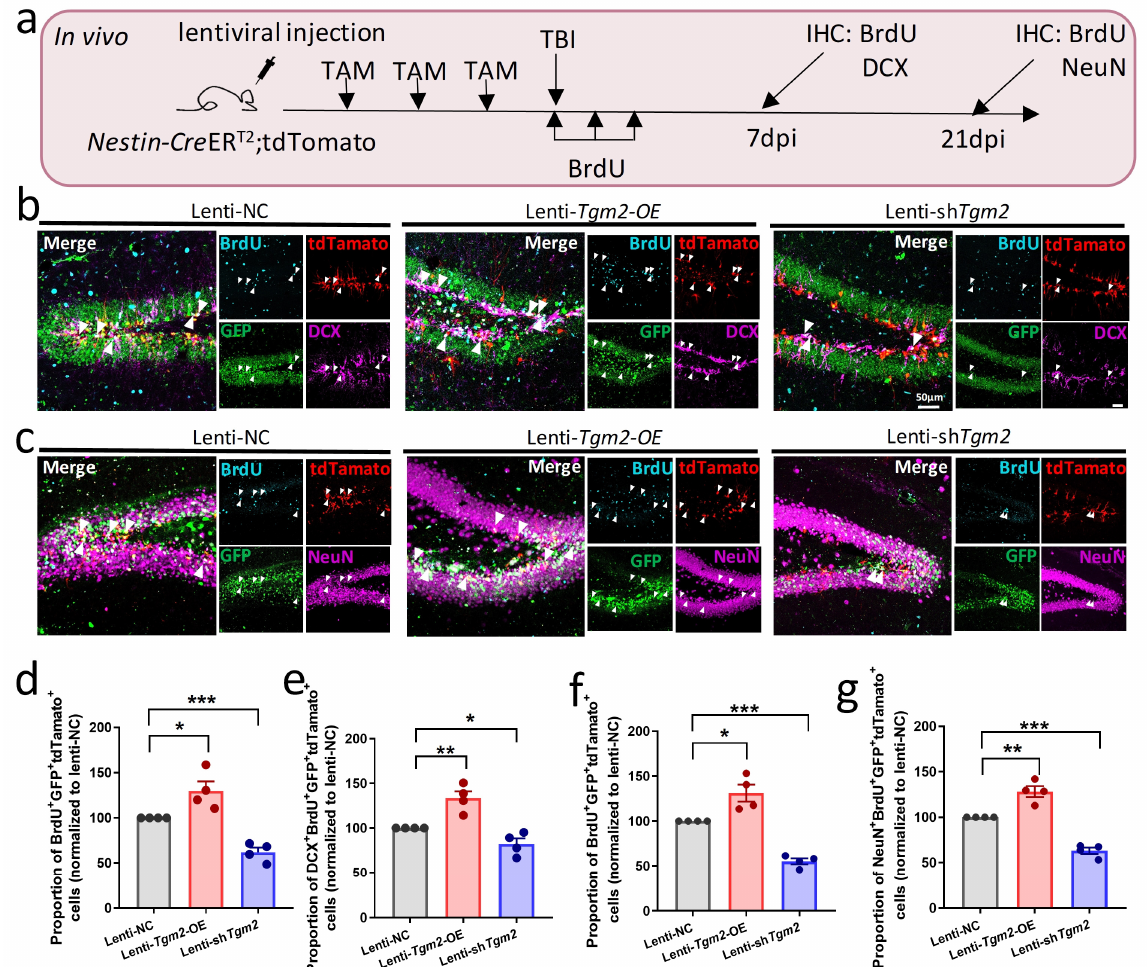
Figure 4. Overexpression of TGM2 promotes neurogenesis after TBI. ( a ) Schematic illustration for analyzing neurogenesis in TBI hippocampi which were injected with lenti-NC, lenti- Tgm2 -OE, or lenti-sh Tgm2 virus. ( b – g ) Representative images ( b , c ) and quantification ( d – g ) of BrdU (blue), DCX (pink) or NeuN (pink) immunostaining of hippocampal sections from Nestin-Cre ER T2 ;tdTomato mice which were injected with lentivirus, tamoxifen, and BrdU at given time windows. Percentages of BrdU + GFP + tdTamato + cells among GFP + tdTamato + cells were quantified to examine proliferative potential of lentivirus-transduced NSPCs at 7 dpi ( c ) and 21 dpi ( f ), respectively. Percentages of BrdU + GFP + tdTamato + DCX + cells (newborn immature neurons) or BrdU + GFP + tdTamato + NeuN + cells (newborn mature neurons) among BrdU + GFP + tdTamato + cells were quantified to determine the ability of neuronal differentiation of lentivirus-transduced NSPCs at 7 dpi ( d ) and 21 dpi ( g ), respectively. Scale bars: 50 μ m. n = 4 mice per group. Data are represented as means ± SEM; two-tailed t -test, * p < 0.05, ** p < 0.01, *** p < 0.001.